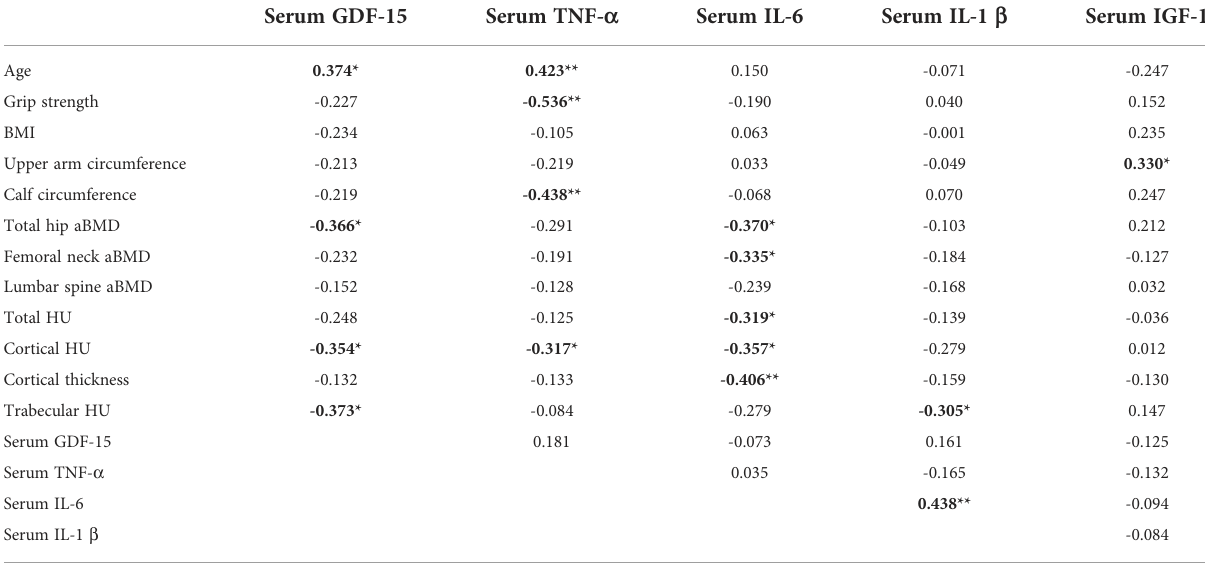
TABLE 5 Relationships among age, handgrip strength, BMI, circumferences of upper arm and calf, serum GDF-15 and cytokine levels, handgrip strength, aBMD of total hip, femoral neck, and lumbar spine, and local bone quality of radial